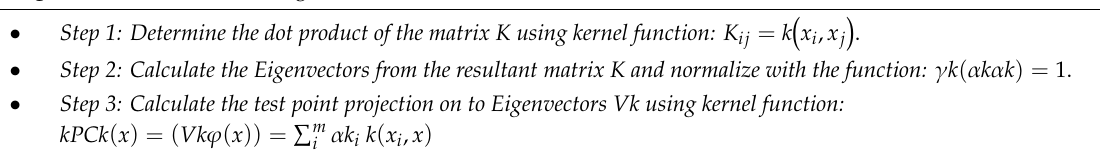
Algorithm 2. Kernel PCA